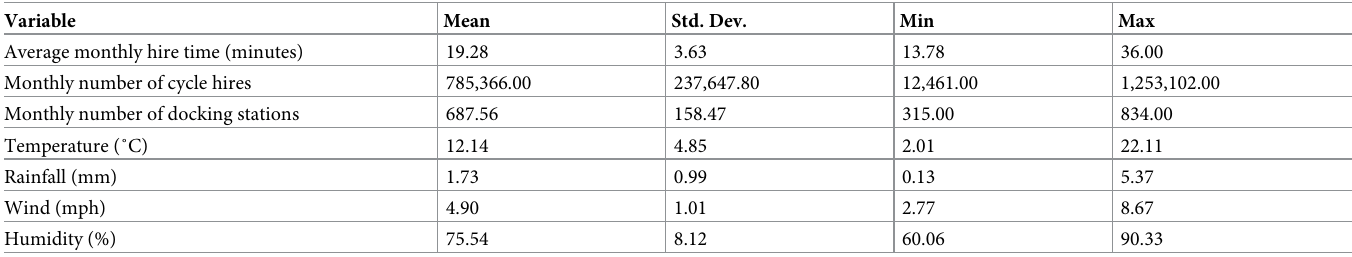
Table 2. Summary of descriptive statistics (July 2010–December